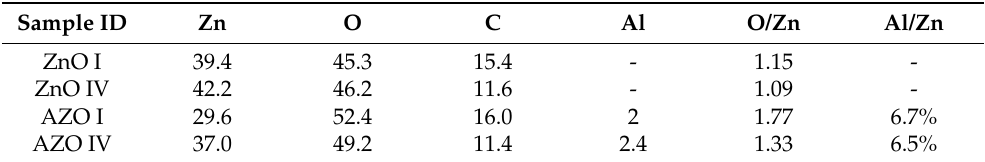
Figure 5. ( a ) XPS survey spectra for ZnO I, ZnO IV, AZO I, and AZO IV surfaces. High resolution of spectra of ( b ) Zn 2p, ( c , d ) Al2p, and ( e–h ) O1s XPS peaks. Table 3. Elemental analysis of ZnO and AZO NRs array surface extracted from XPS spectra. The content of each element is given in at